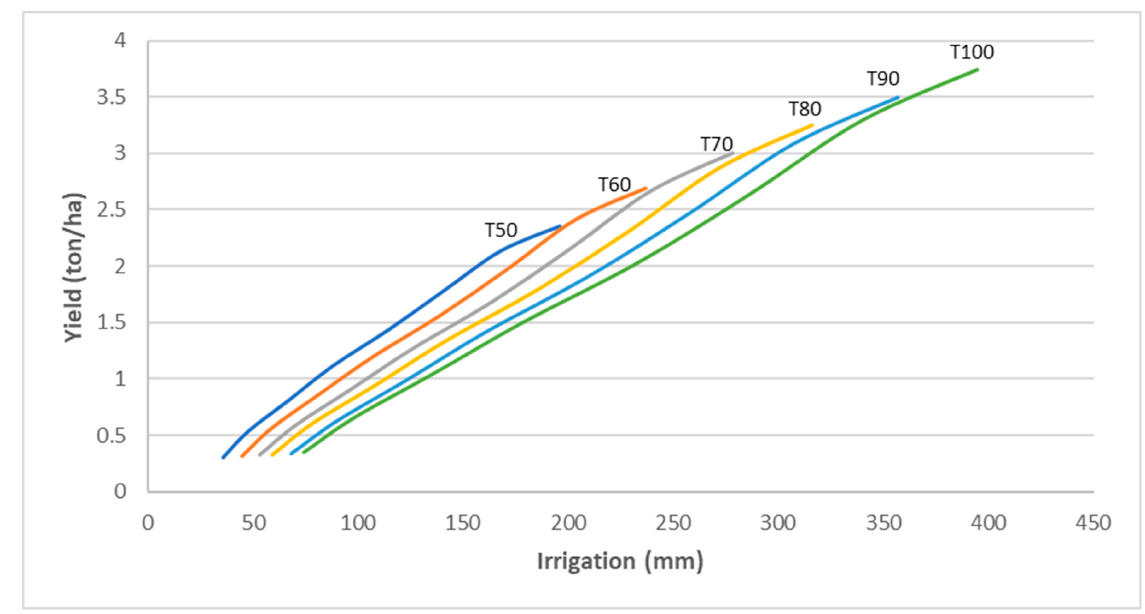
Figure 4. The crop production yield versus the irrigation level for the winter wheat crop.